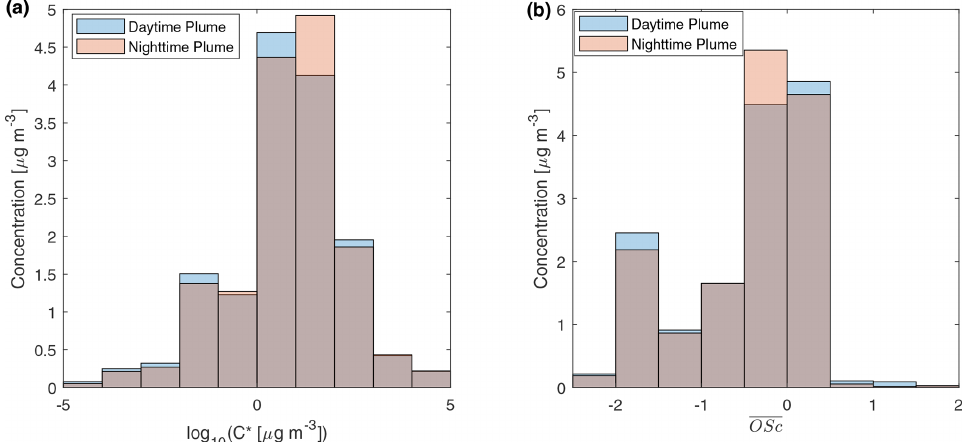
Figure 4. Mass distribution of speciated compounds in different (a) effective saturation concentration and (b) average carbon oxidation state bins. The daytime plume is from a sample in the 11 October plume described in Fig. 2a. The nighttime sample is from a sample in the 11–12 October plume in Fig. 2b. The gray parts of the bar show the overlaps of the daytime plume and the nighttime plume samples.